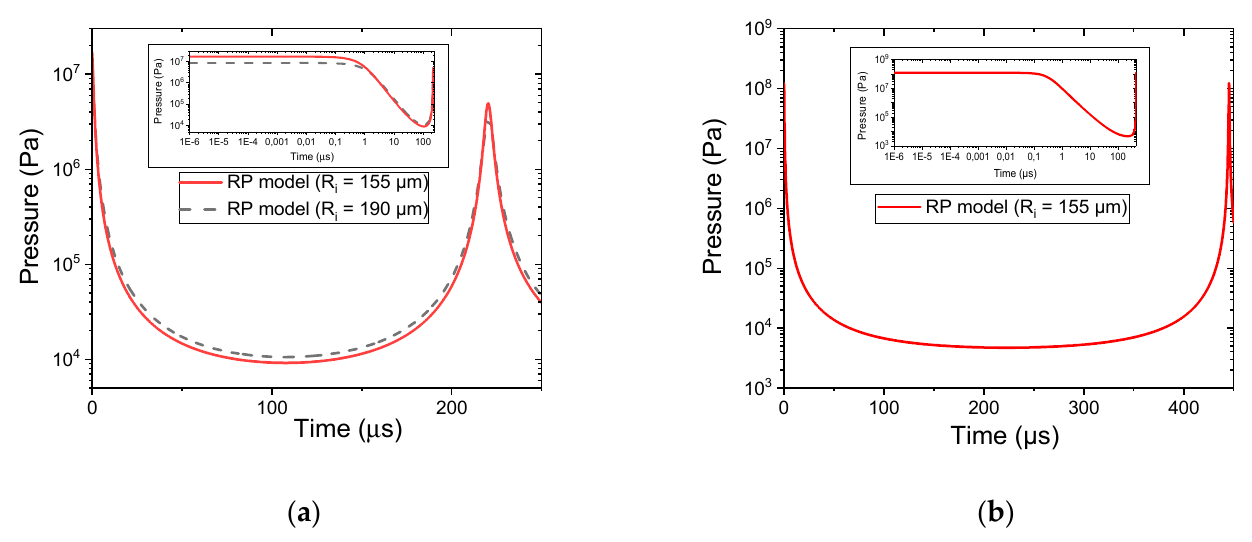
Figure 8. Time evolution of the pressure in the bubble estimated by the modified Rayleigh–Plesset modeling for ( a ) cathode regime and ( b ) anode regime.